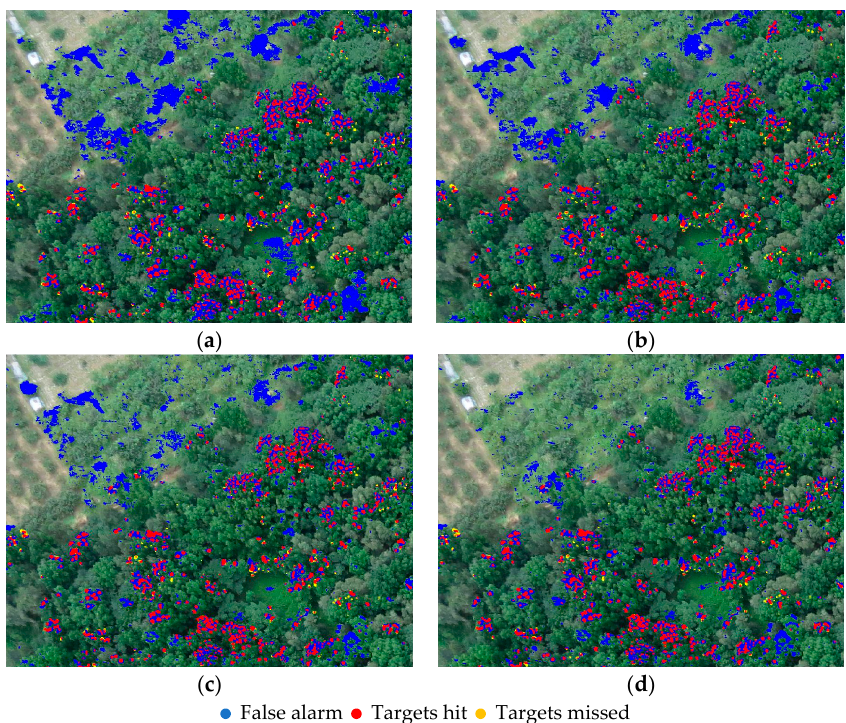
Figure 15. Detection results highlighted with different colors of 4 algorithms in Region 1. ( a ) CEM ( b ) Subset CEM ( c ) Sliding Window-based CEM (SW CEM) ( d ) Adaptive Window-based CEM (ASW CEM).